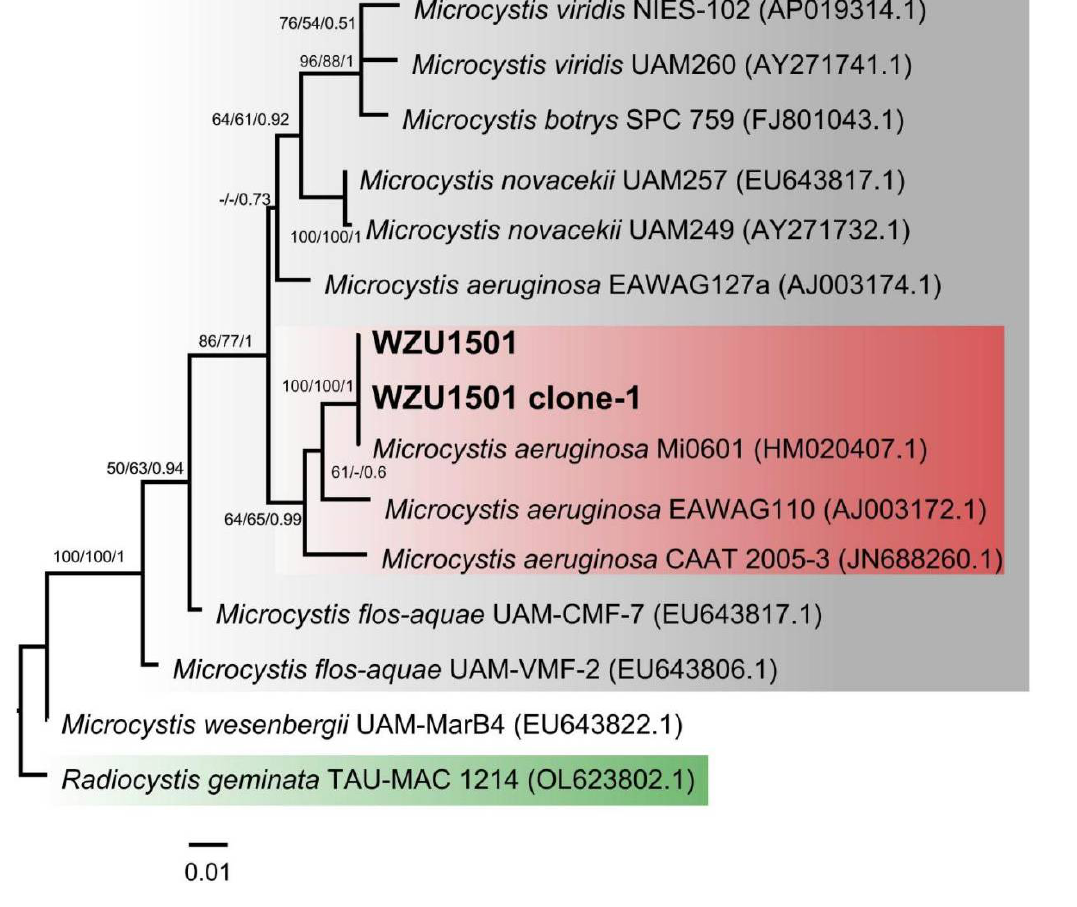
Figure 3. Phylogenetic tree based on cpc -BA gene sequences (499 bp) with maximum-likelihood (ML) analysis. Bootstrap values of NJ/ML/BI methods greater than 50% are showed on the ML tree. The studied species was indicated in bold.